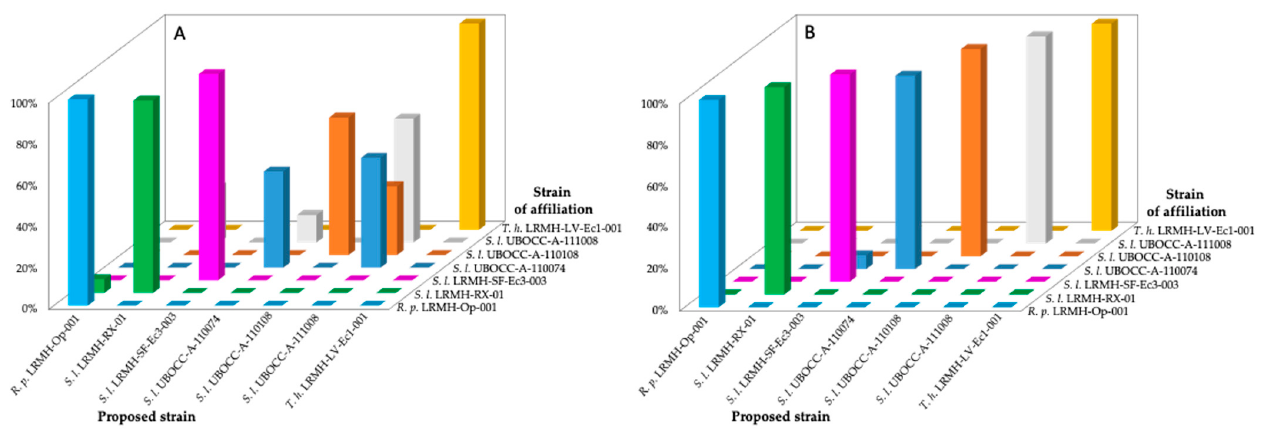
Figure 5. Confusion matrix obtained for the discrimination of the strains after growth in liquid medium. Min–max normalization ( A ), or Vector normalization ( B ). R. p. , Rhodonia placenta . S. l. , Serpula lacrymans . T. h. , Trichoderma harzianum .